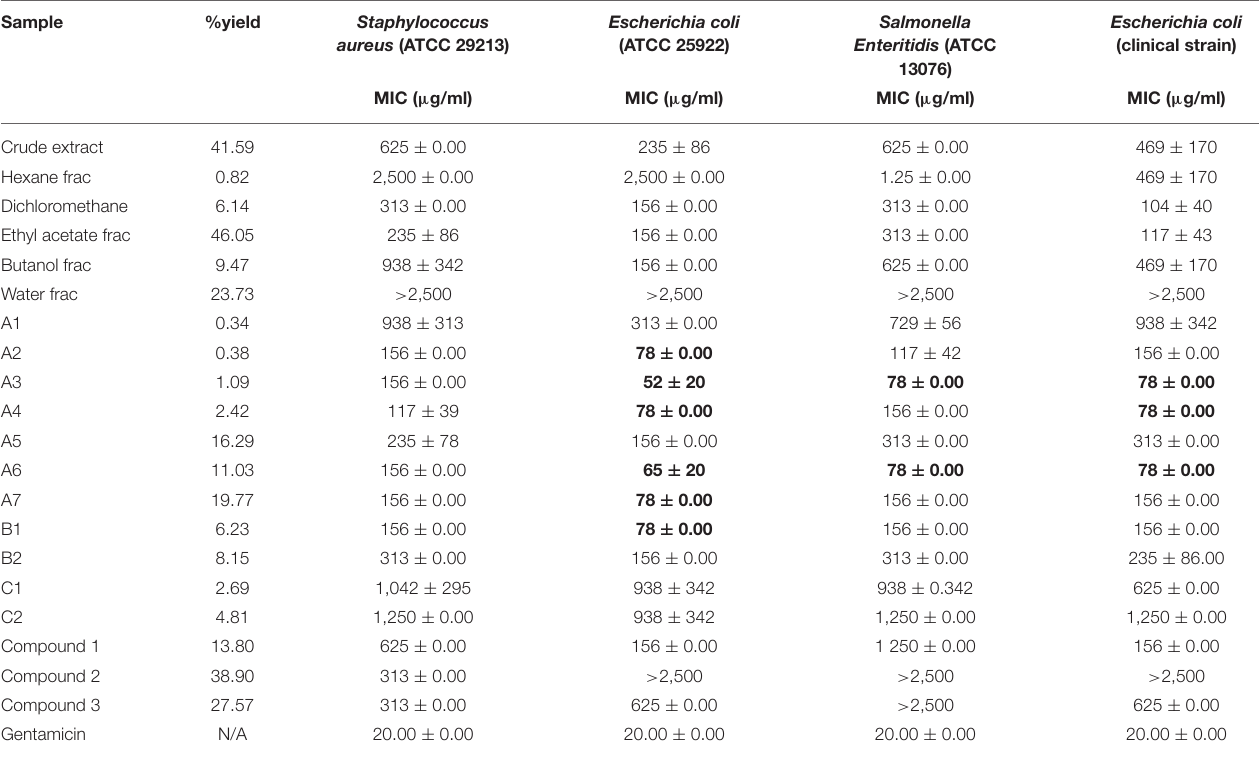
TABLE 1 | Yield and minimum inhibitory concentrations (MICs), and of S. singeuana fractions against ATCC strains. Sample